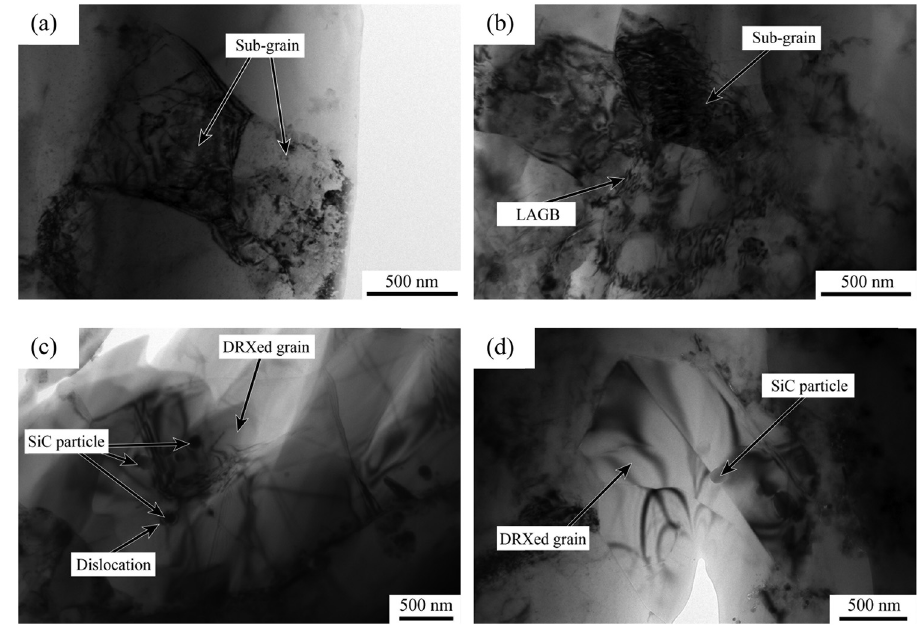
Figure 9: TEM images at di ff erent strain rate deformation and deformation temperature of 530°C: ( a ) 5 s − 1 , ( b ) 1 s − 1 , ( c ) 0.1 s − 1 , and ( d ) 0.01 s − 1